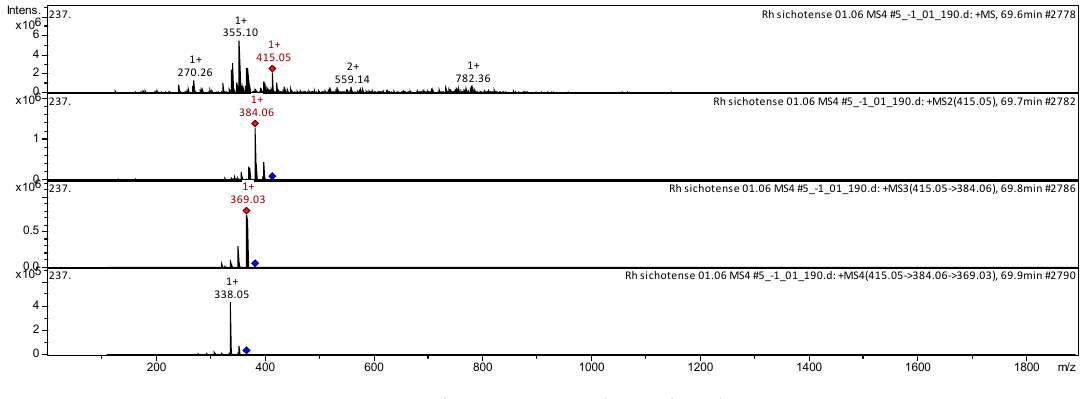
Figure 5. CID spectrum of Beta-sitosterin from Rh. sichotense , m / z 415.05.